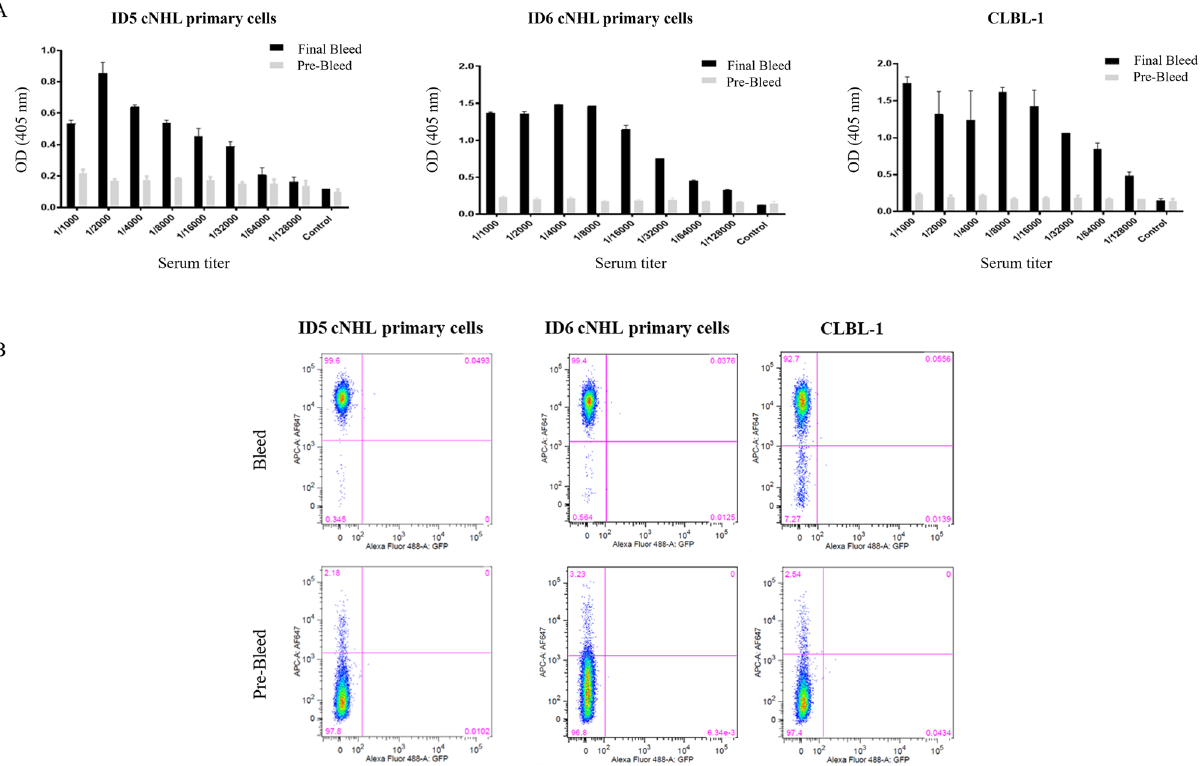
Figure 2. Characterization of rabbit immune response. To evaluate the rabbit immune response, antibody titers were monitored by a cell ELISA and flow cytometry analysis using the cNHL primary cells and CLBL-1 cell line. Pre-bleed sera was used as control. ( A ) Serum titration by ELISA. 5 × 10 4 cells were incubated with serial dilutions of rabbit serum (from 1/1000 to 1/32,000). Cells were incubated with secondary antibody goat-α anti-rabbit IgG-Fc specific HRP at 1/3000. The rabbit presented a high response against cNHL primary cells and CLBL-1 cell line with a high serum titer (1/64,000), in opposition to the pre-bleed serum. ( B ) Binding properties against cNHL cells were also analyzed by flow cytometry. Cells were incubated with the rabbit pre-bleed and final bleed (1/3000) and with the secondary antibody Alexa Fluor 647 Goat Anti-Rabbit IgG (1/10,000). The flow cytometry analysis confirmed a high serum activity of the rabbit against the primary cNHL cells (ID5 and ID6 patient cells) and CLBL-1 cell